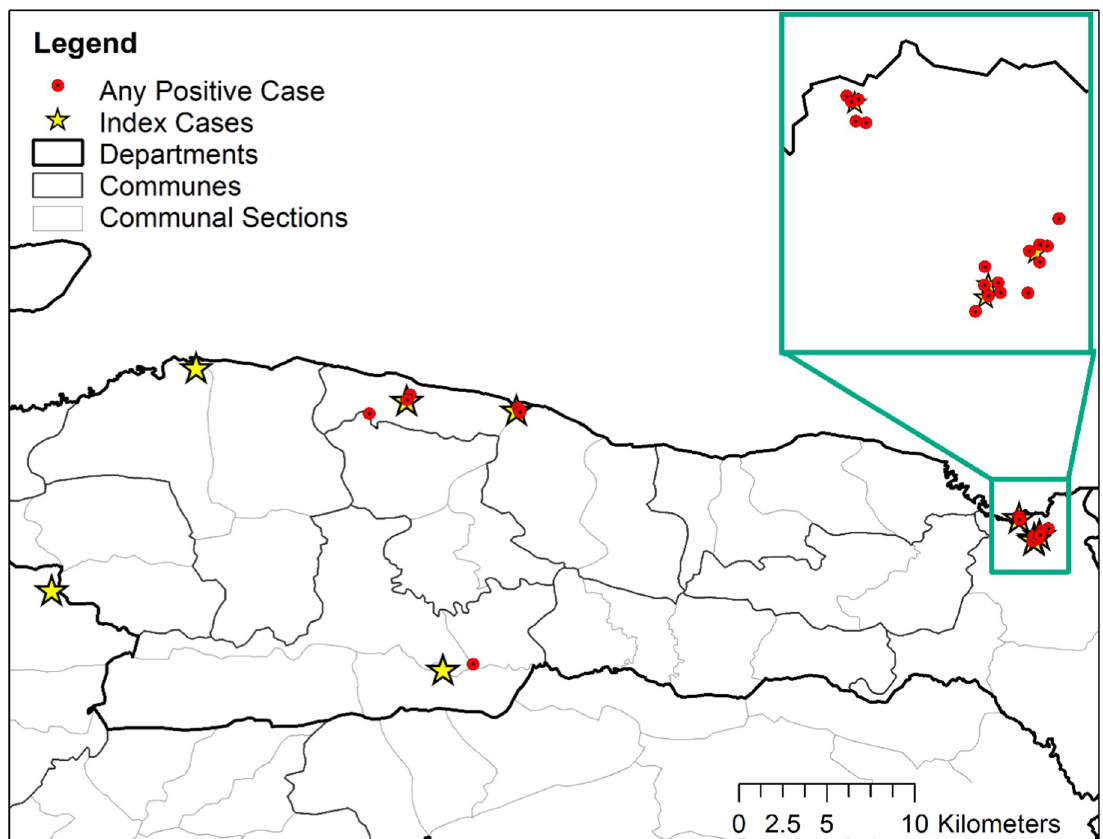
Fig 2. Locations of individuals positive for circulating filarial antigen (CFA) identified through purposive or random sampling in relation to their index case, Nippes Department, Haiti July-August 2019. Exact locations are jittered for participant confidentiality. Shapefiles for administrative boundaries are from the Centre National d’Information Geo-Spatiale and are available at https://data. humdata.org/dataset/hti-polbndl-adm1-cnigs-zip.